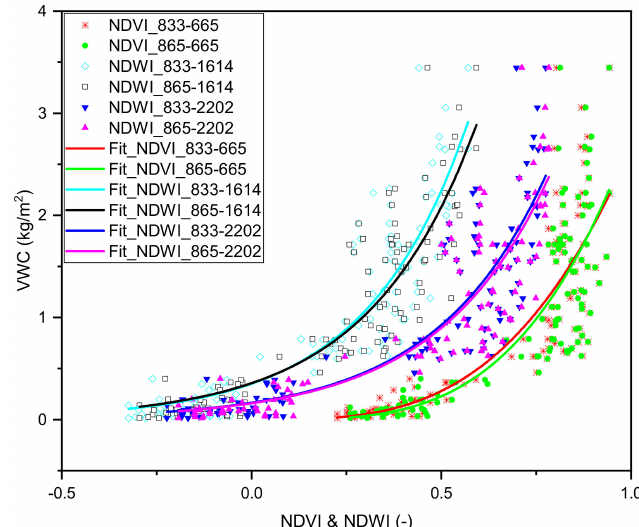
Figure 2. Scatter plots and the fitted functions of ground measured VWC against Sentinel-2-derived NDVIs / NDWIs. NDVIs and NDWIs derived from di ff erent bands of Sentinel-2 show similar correlation, as can be determined from Table